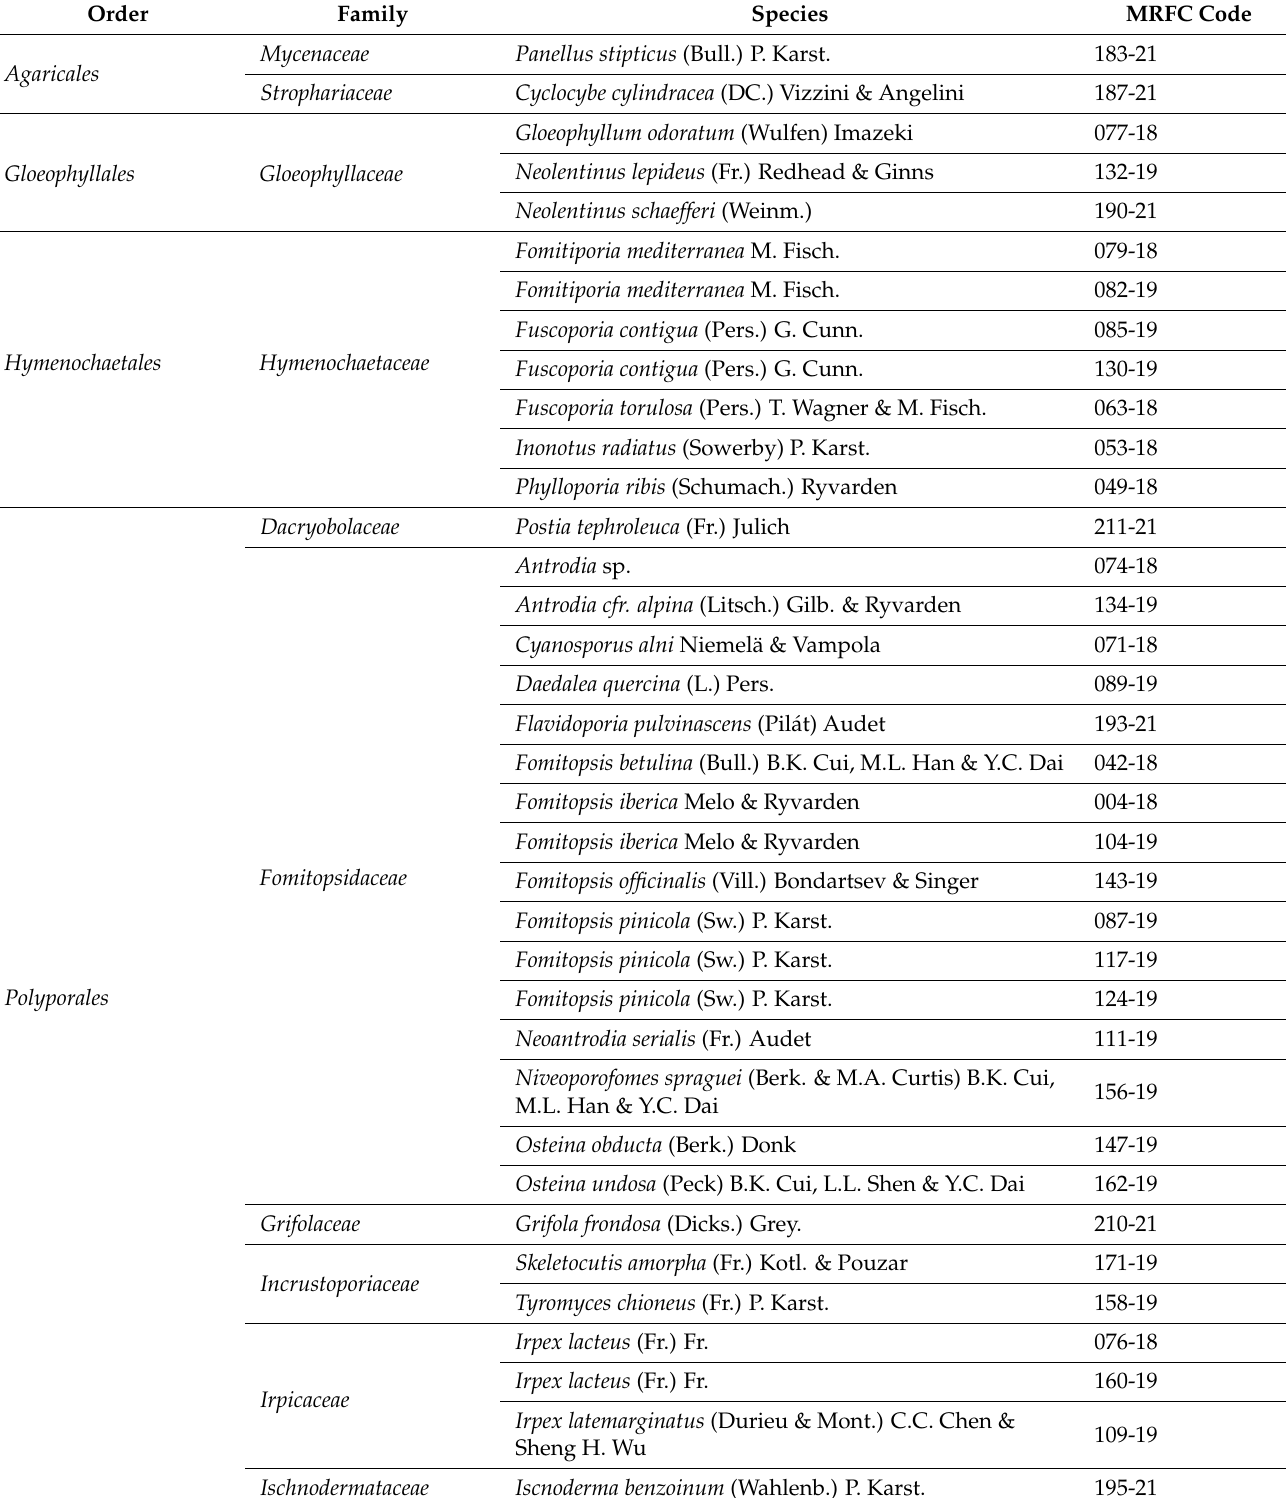
Table 2. Taxonomy of the isolated strains and reference to the code within the Mogu S.r.l research fungal collection (MRFC). Taxonomy relies on MycoBank